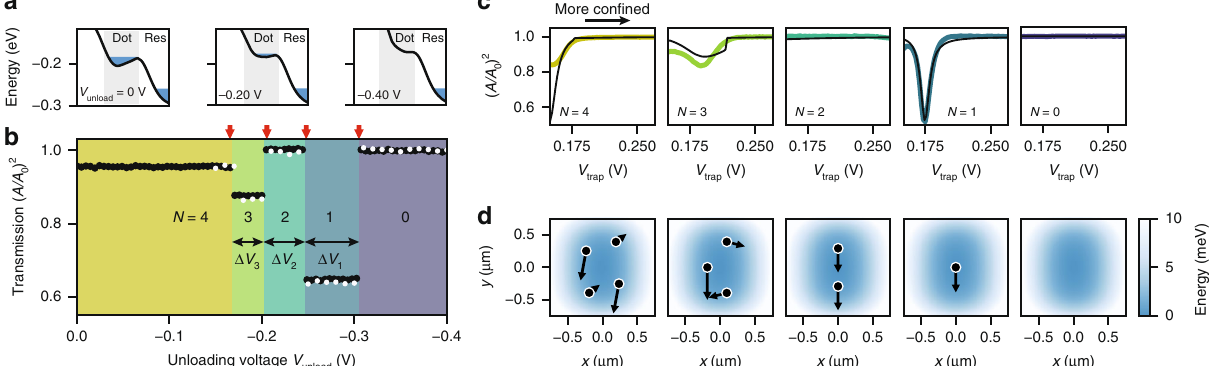
Fig. 3 Resonator signatures of few-electron clusters. a Schematic of the unloading procedure. At the unloading voltage, the dot ’ s trap depth decreases for ¼ (cid:3) 0 : 4 V. b With decreasing V more negative V . No electrons can occupy the dot at V , sudden changes in the resonator transmission unload unload unload ¼ 0 : 175 V and V ¼ 0 V and averaged 500 times) indicate that electrons leave the dot. We observe fi ve distinct plateaus (black circles, measured at V trap tg that are reproduced after reloading the dot 8 h later (white circles), and are associated with a constant number of trapped electrons N . Red arrows indicate predicted escape voltages for N ¼ 4 to 1 electrons (left to right) from a single-parameter model, see Methods and Supplementary Table I. c Resonator ¼ 0 : 15 V electron trapping is unstable. transmission with one to four electrons in the dot, measured by varying the trap curvature using V . Below V trap trap The solid black lines are simulated cavity responses (see Methods) and agree qualitatively with the measured resonator transmission spectra. The discontinuity in the simulation for N ¼ 3 is due to a sudden change in position of the electrons, and is not expected to be visible in the averaged data. ¼ 0 : 175 V. The arrows show the electron motion for the d Simulated electron con fi gurations in the approximated electrostatic potential, shown for V trap eigenmode that is most strongly coupled to the resonator. The microwave electric fi eld is in the y